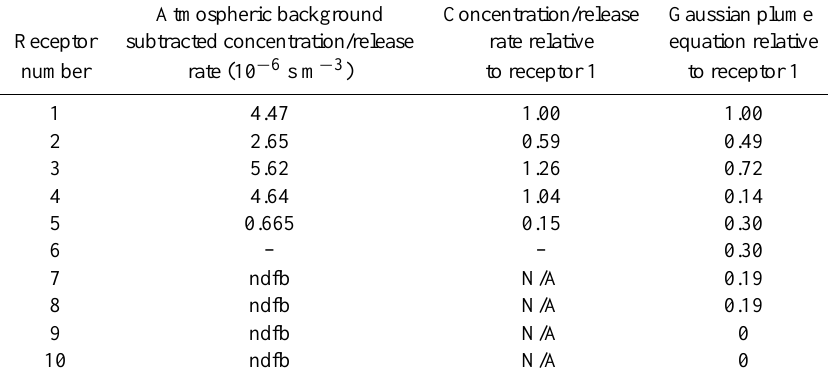
Table 1. Results (10min averages) from the first CityFlux Perfluorocarbon Tracer Experiment. The sigma parameters were calculated according to σ y =0.22x(1+0.0004x) − 1 / 2 and σ z =0.20x where x is the source receptor distance.